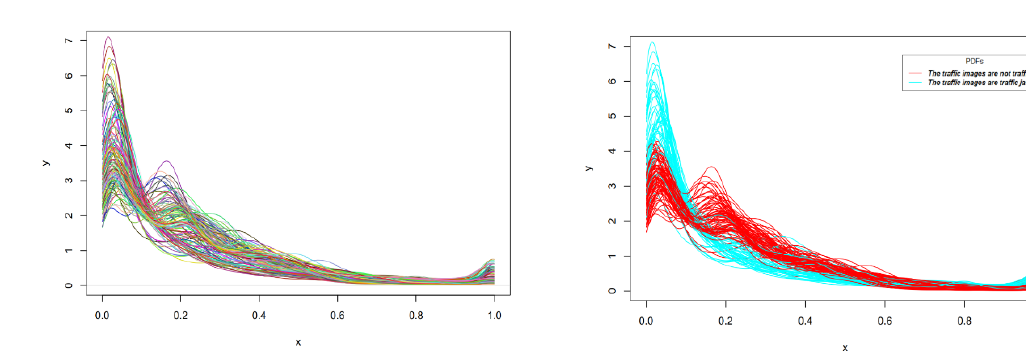
Fig. 7: 121 PDFs estimated by 121 tra(cid:30)c images on Nguyen Huu Tho Street at night in example 3 before clustering.